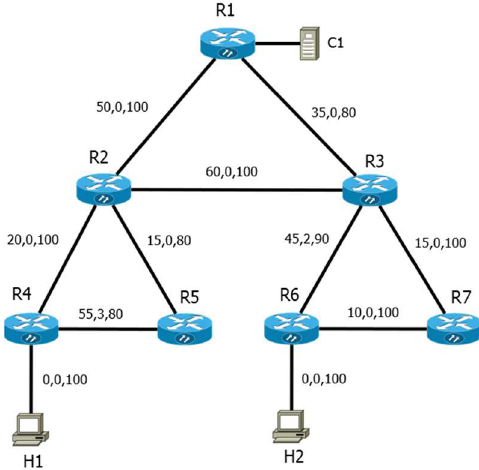
Figure 4. Example topology. Metrics: delay (ms), packet loss rate (%), and bandwidth (Mbps). Table 3. Example topology adjacencies matrix for coding representation. The path source: H1 and